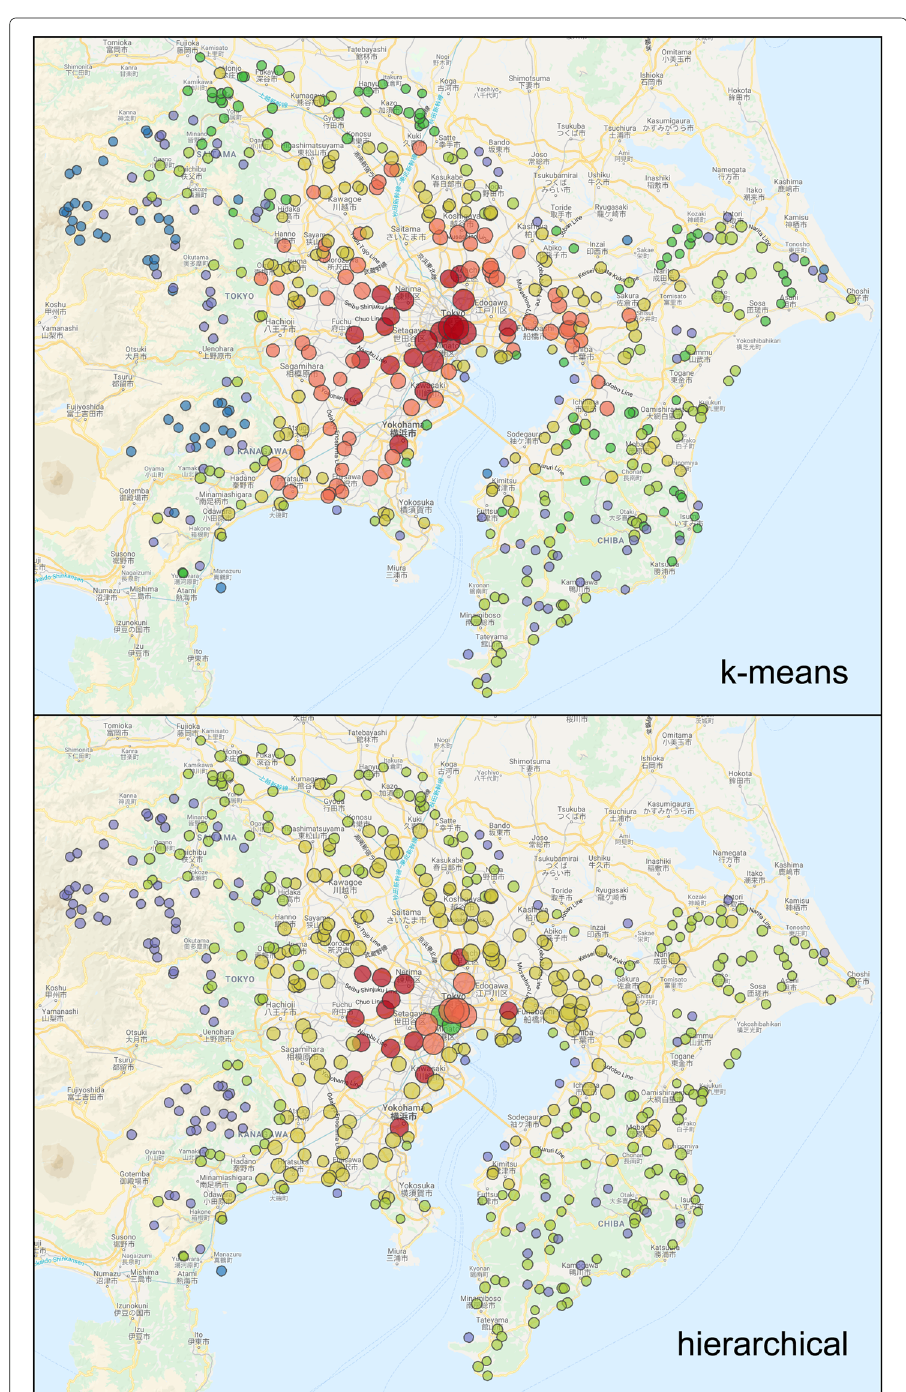
Fig. 8 Clustering into 7 groups using k-means (top) and hierarchical (bottom) methods using all 300 core measures collected. Marker size corresponds to the mean value across the variables and colors represent the cluster number. There are clear and important differences in the clusters found between the two methods. Map data ©2019